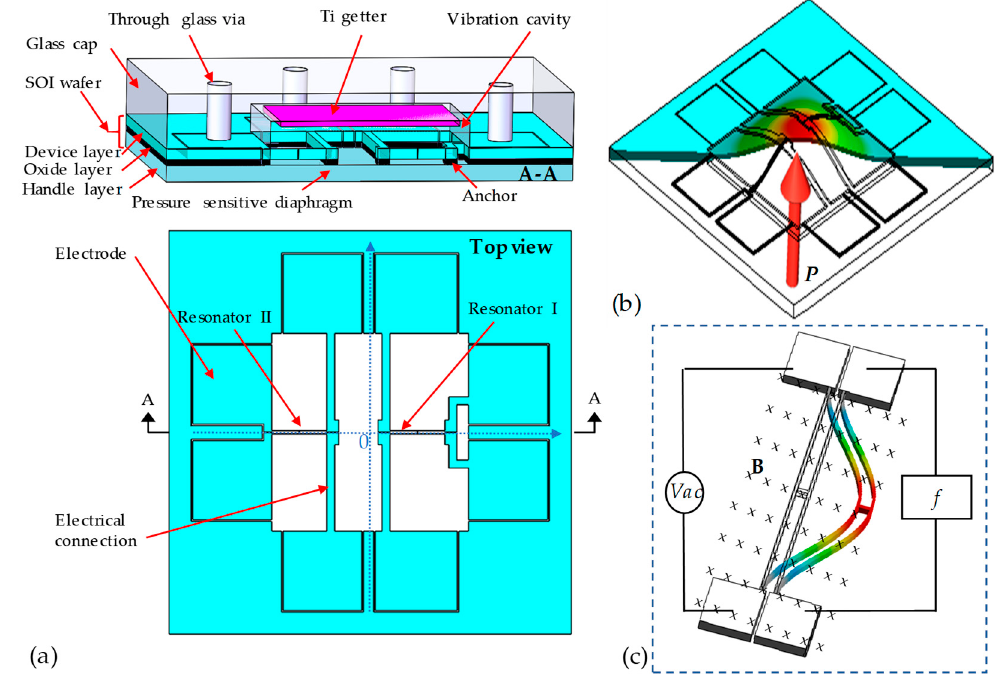
Figure 1. Schematic of the proposed resonant pressure microsensor: ( a ) The proposed pressure microsensor consists of an SOI wafer (including a pressure-sensitive diaphragm, two H-shaped resonators, and eight electrode pads) and a glass cap (including a vibration cavity with getter inside and eight through-glass vias); ( b ) Details of the sensing elements when pressure applied. The pressure-sensitive diaphragm bends under the pressure, which changes the axial stresses of the resonators; ( c ) The resonator is excited based on electromagnetic forces and detected based on electromagnetic inductions.